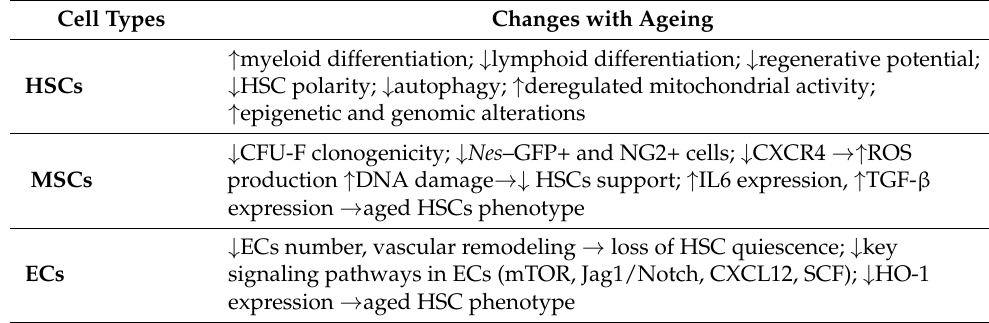
Table 3. Phenotypic and functional aging-related alterations in HSCs and BM niche